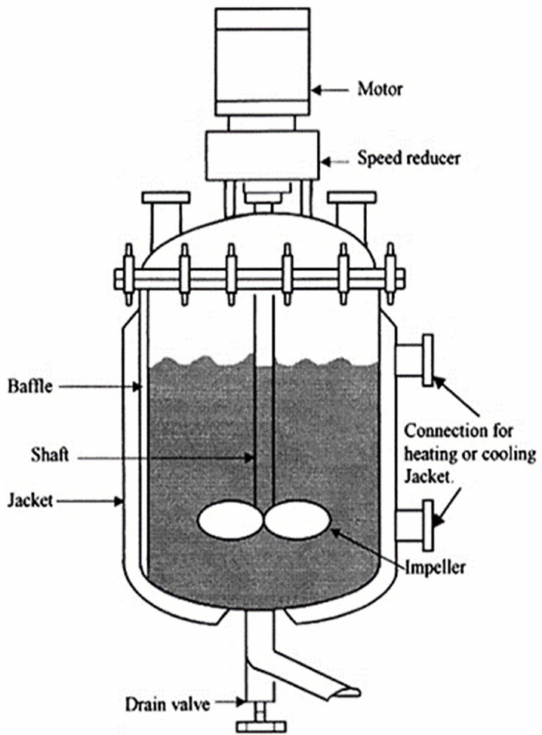
Figure 2. Hydrogel fabrication method in controlled batch reactor chamber. Parts such as motor, speed reducer, baffle, shaft, jacket, connection for heating or cooling, impeller, and drain valve are presented [19]. Adapted with permission from Elsevier,